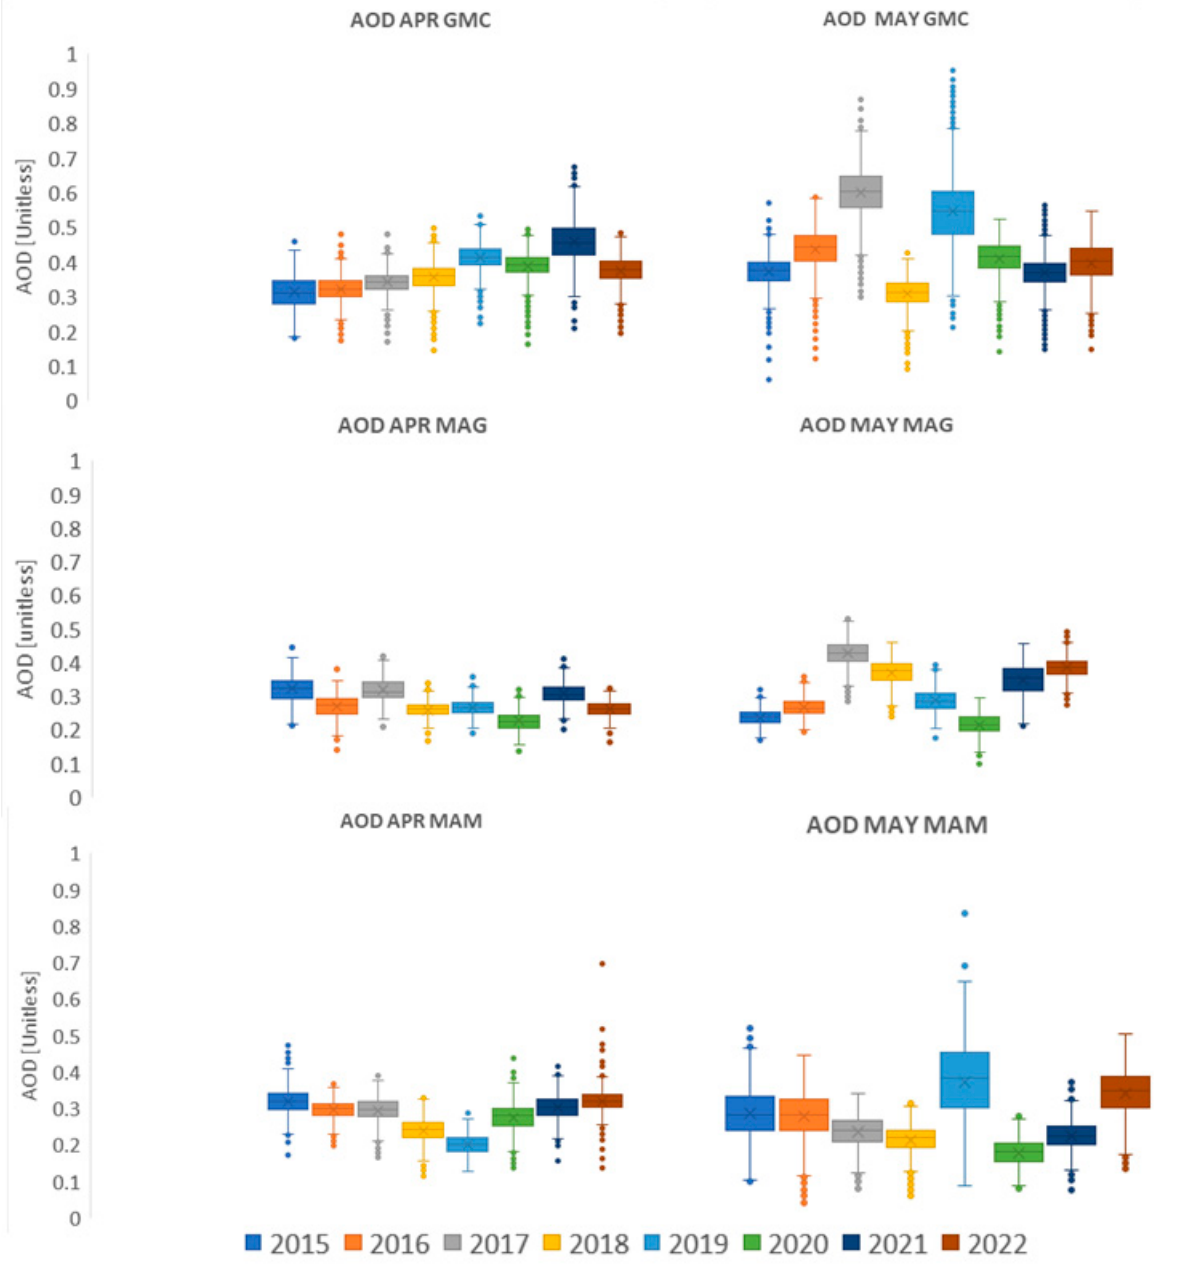
Figure 3. AOD (dimensionless) in GMC, MAG, and MTY in April and May 2015–2022.